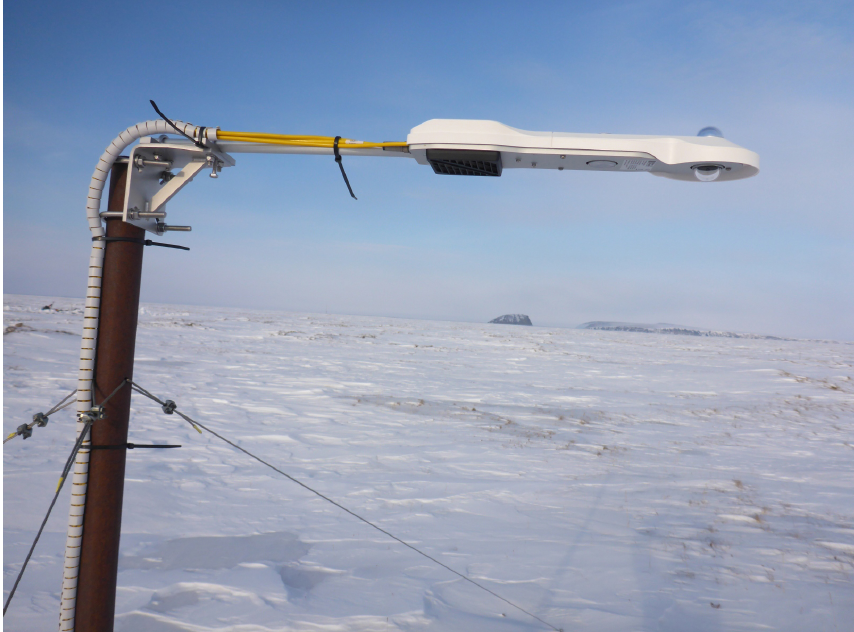
Figure B3. Kipp & Zonen CNR4 radiation sensor (including CNF4 ventilation unit) for measuring incoming and outgoing shortwave and longwave radiation installed on 22 August 2014.